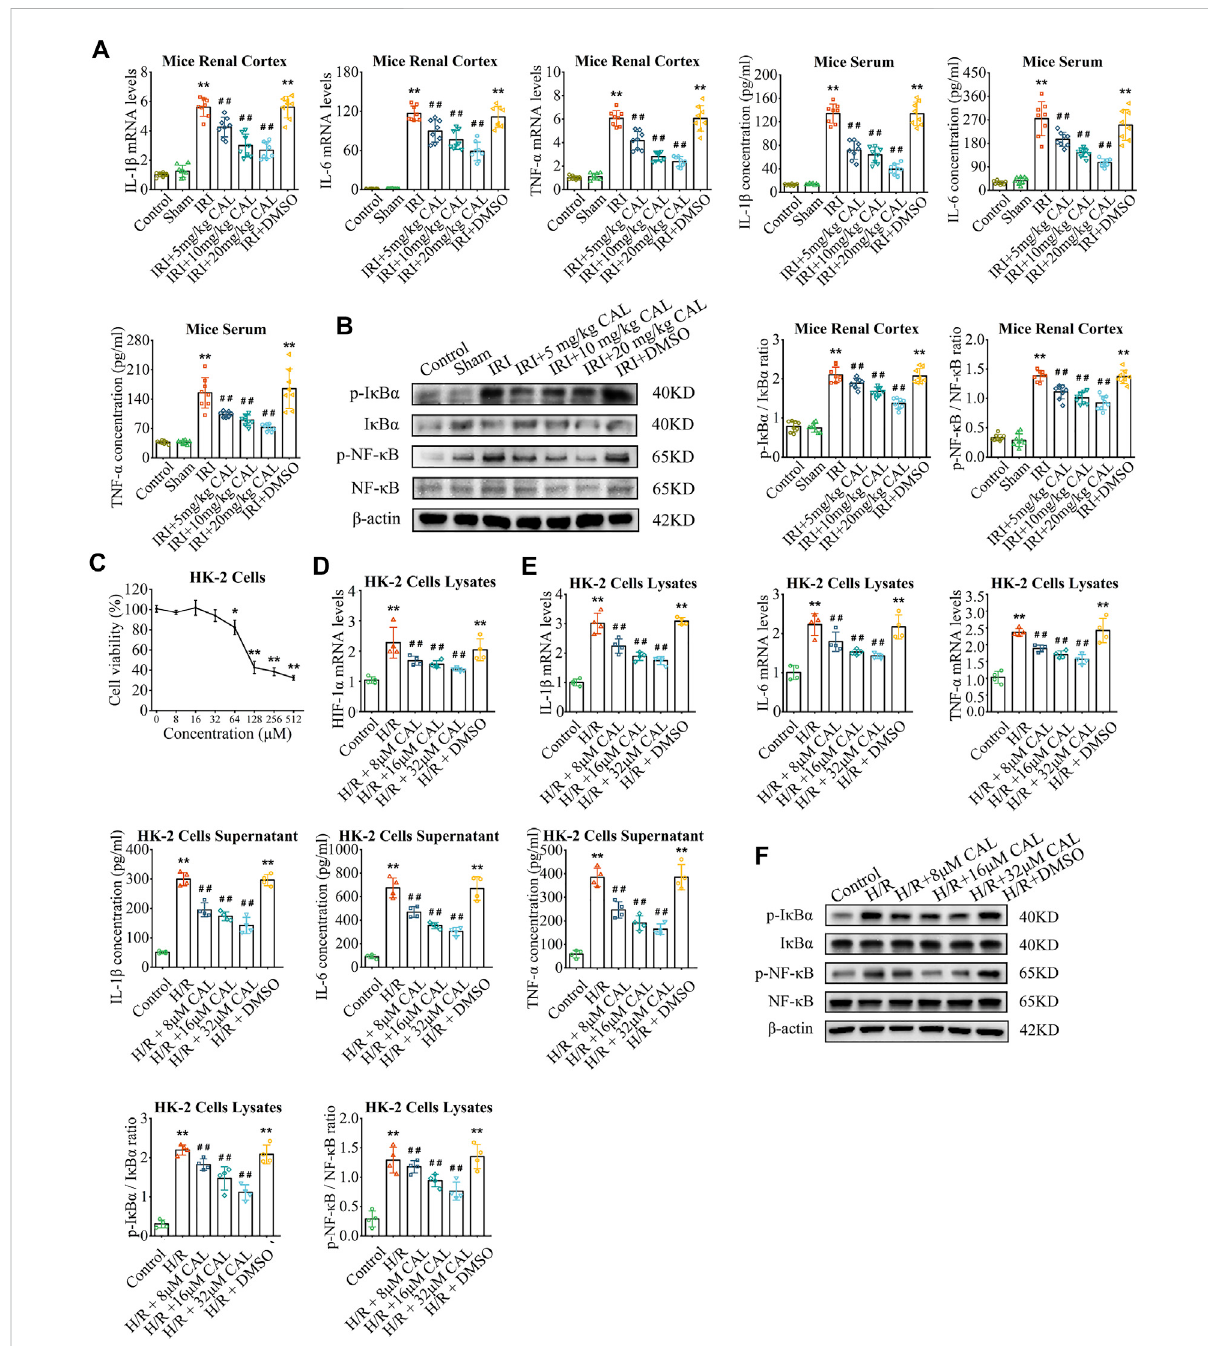
FIGURE 2 CALamelioratedin fl ammationresponseinmiceafterIRIandH/R-inducedHK-2 cells. (A) IL-1 β ,IL-6,andTNF- α mRNAlevels inkidneysamples and IL-1 β , IL-6, and TNF- α concentrations in mice serum of different groups. (B) The protein levels of p-NF- κ B/NF- κ B and p-I κ B α /I κ B α in kidney samples of different groups. ** p < 0.01 vs. sham group. ## p < 0.01 vs. IRI group. n = 8 per group. (C) Results of CCK-8 testing of different concentrationsofCALonHK-2cells.* p < 0.05,** p < 0.01vs.controlcells. (D) TheHIF-1 α mRNAlevelindifferentcellgroups. (E) IL-1 β ,IL-6,and TNF- α mRNAlevelsincelllysatesandIL-1 β ,IL-6,andTNF- α concentrationsinsupernatantofdifferentgroups. (F) Theproteinlevelsofp-NF- κ